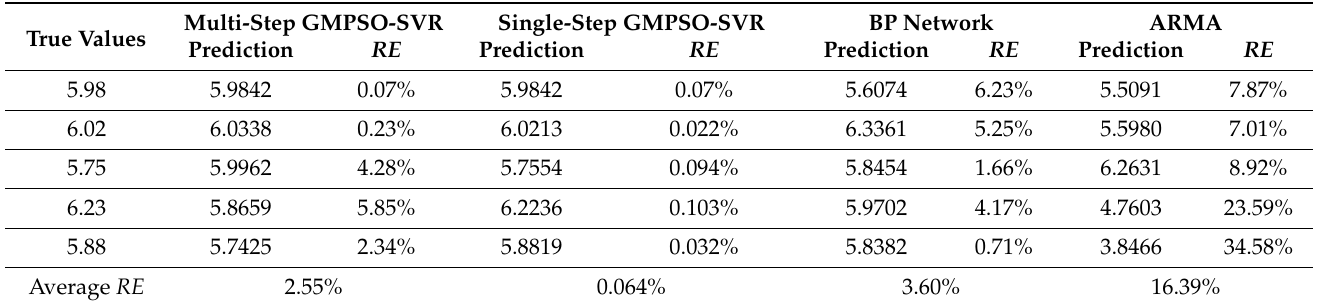
Table 5. Comparison of different prediction